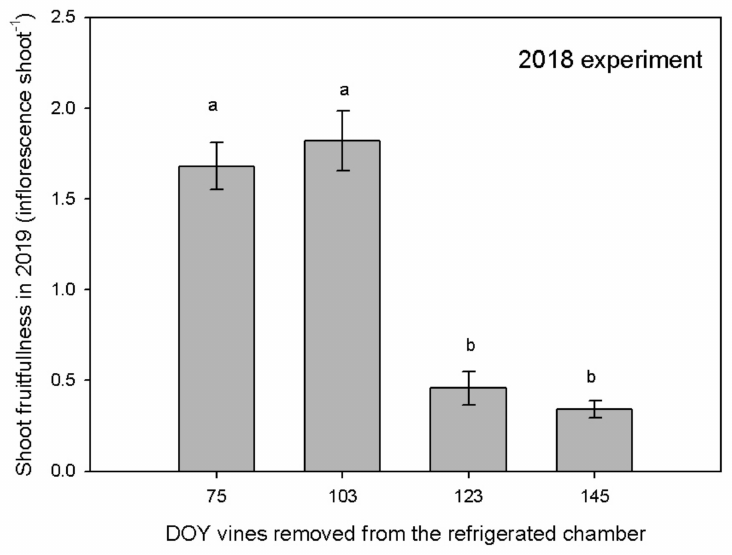
Figure 11. Shoot fruitfulness in 2019 in Montepulciano vines removed from the cold storage on DOY 75, 103, 123, and 145 in 2018. Mean ± SE ( n = 4). Different letters indicate statistically significant means per p < 0.05 (Tukey